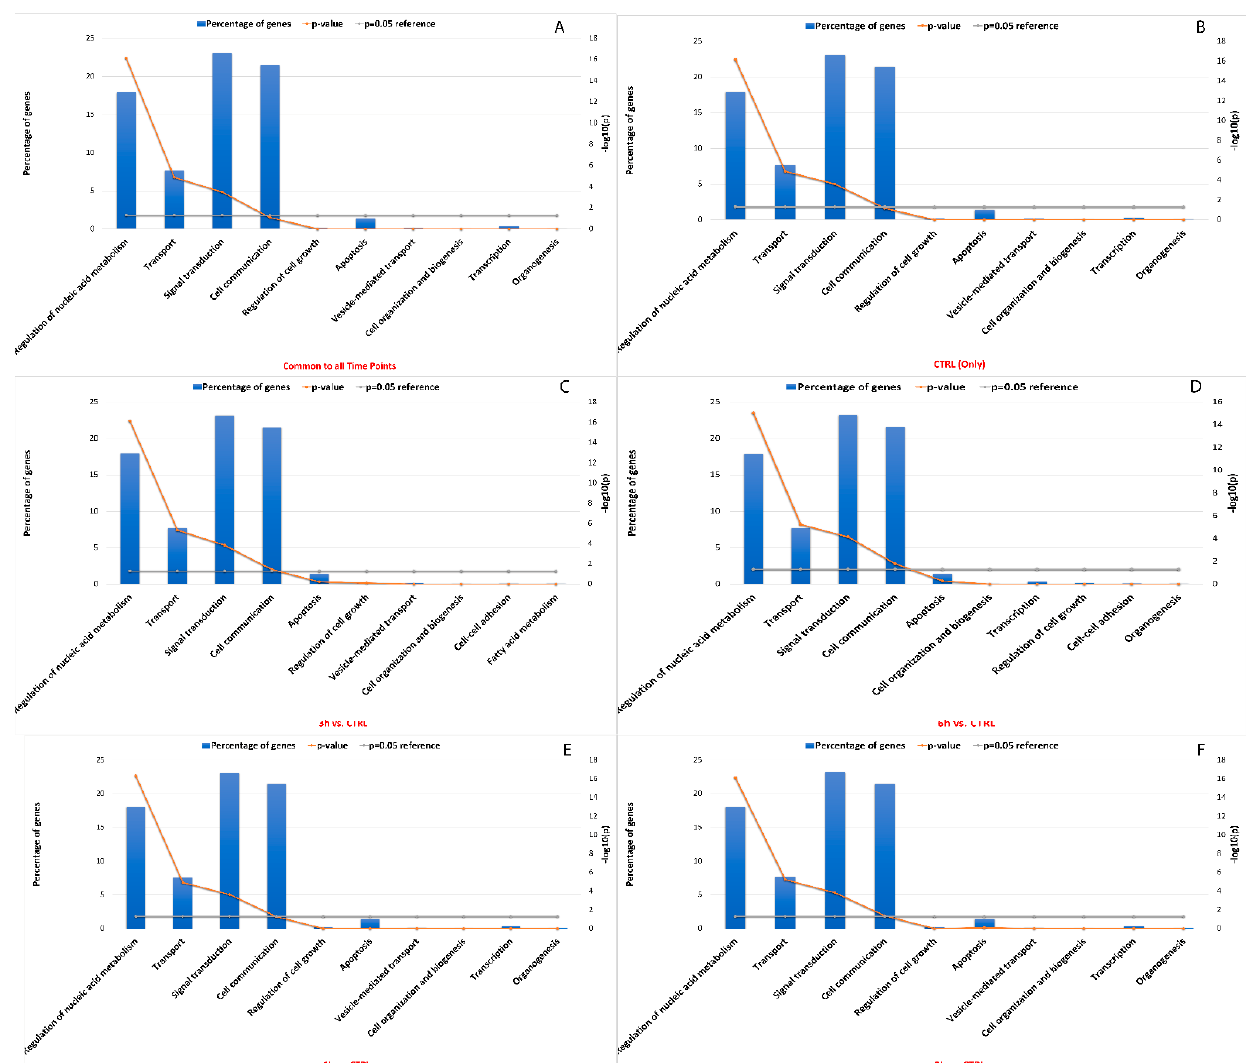
Figure 9. GO and KEGG enrichment of miRNA target genes with the highest number of editing sites. The vertical bar plots show the percentage of miRNA target genes involved in top ranked pathway enrichment analyses, considering genes common to all time points ( A ), only in the control samples ( B ), and in the other time points ( C – F ). The significance of the hypergeometric test ( − log 10 of p -value) is represented by the broken orange line. The first five pathways showed the highest number of miRNA target genes statistically associated.